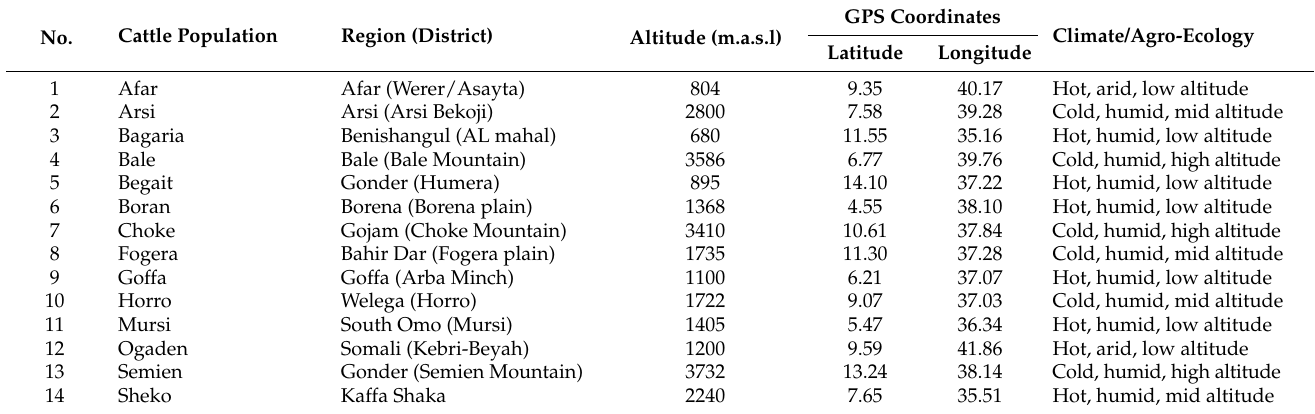
Table 1. Ethiopian cattle populations, regions of sampling locations, altitudes, GPS coordinates, and